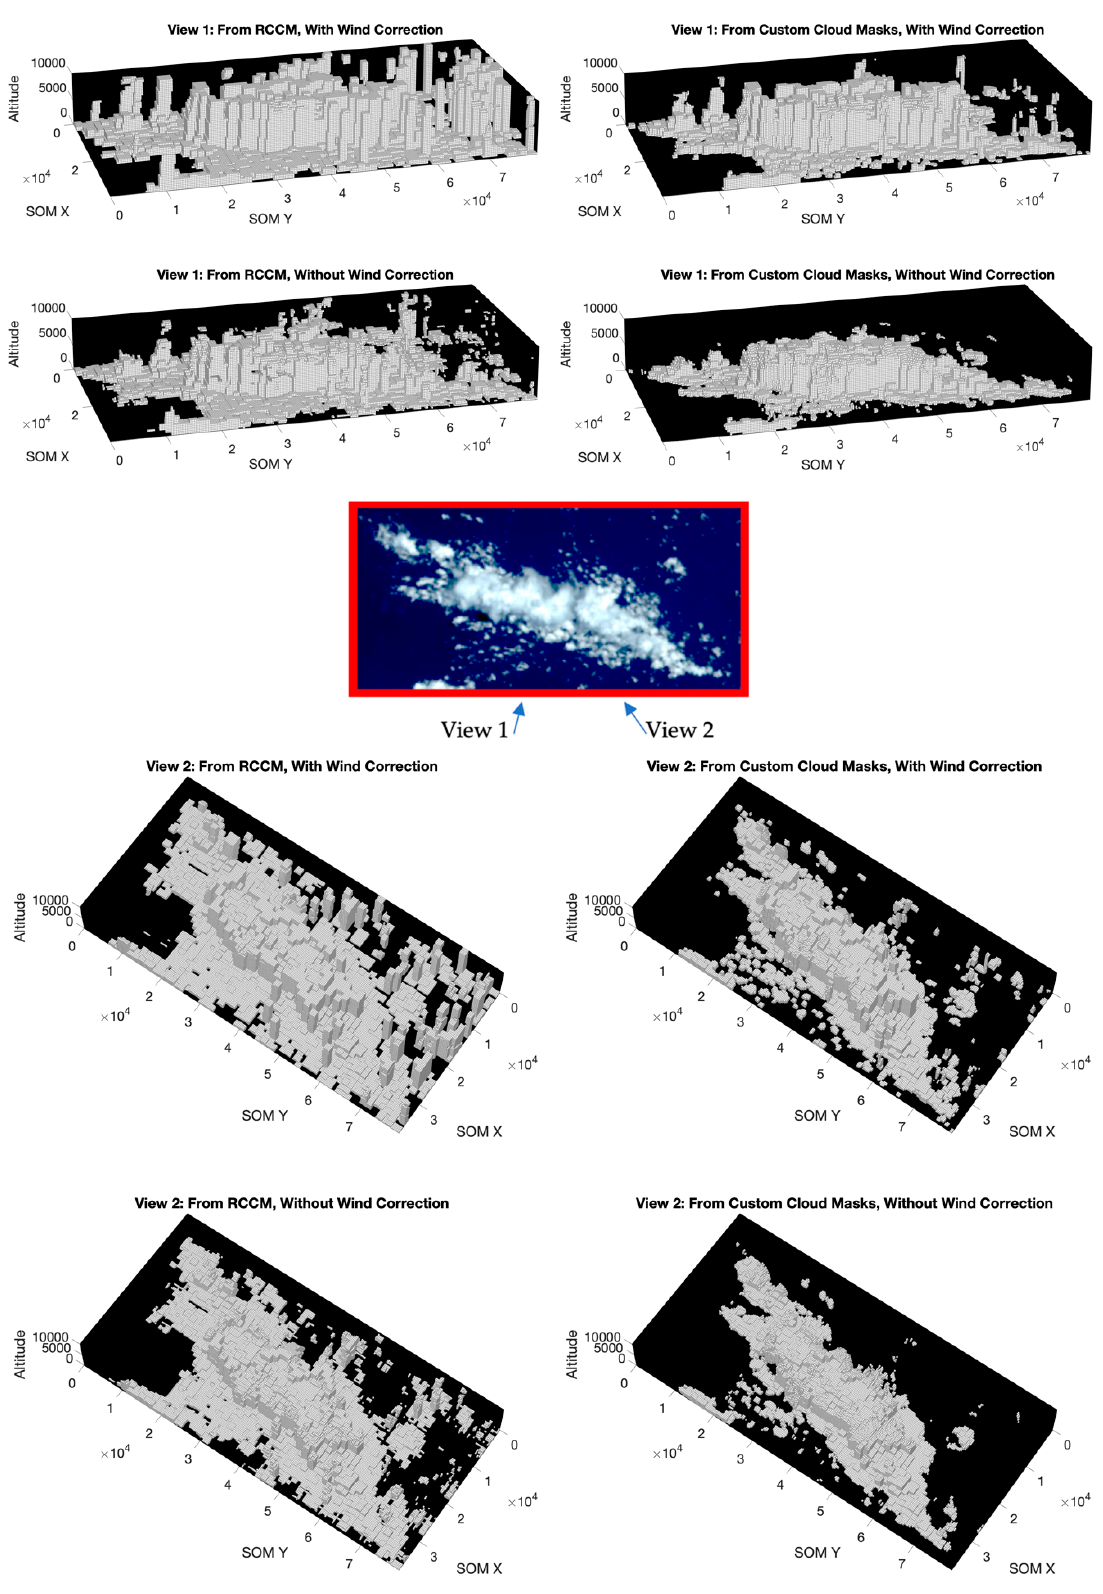
Figure 9. The reconstruction results for four different cases at two different viewing perspectives. The units are all in meters. The red box at the center is the overhead (nadir) RGB image of the reconstruction region, with SOM X increasing downward and SOM Y rightward.